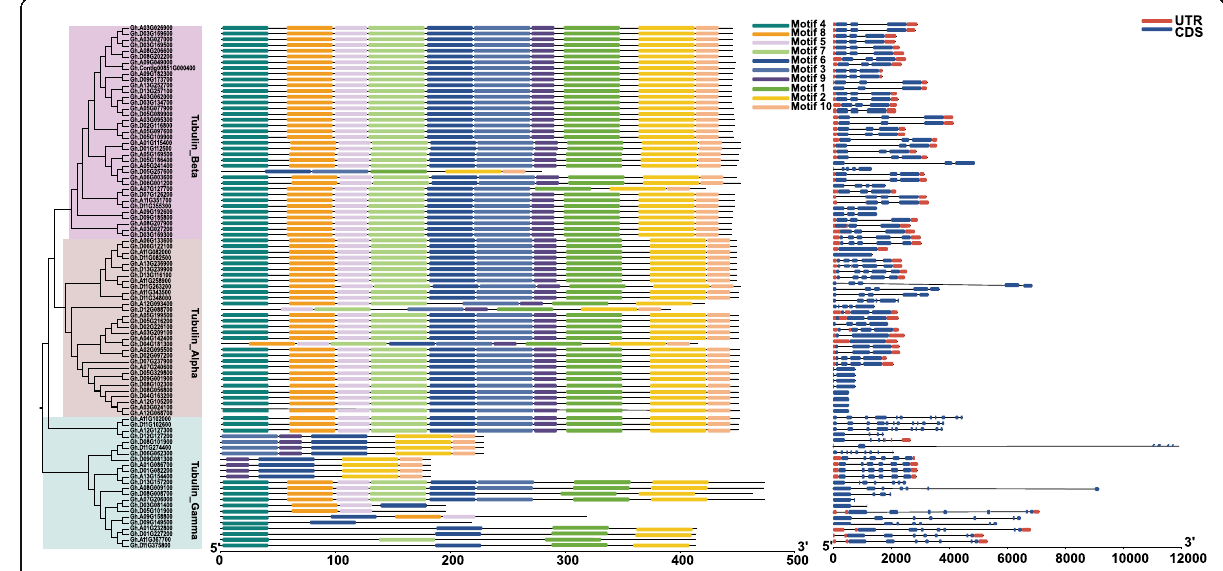
Fig. 2 Phylogenetic relationship, conserved motif, and gene structural characterizations analysis of tubulin genes in G. hirsutum . A neighbor- joining phylogenetic tree was created using the MEGA7 program, conversed protein motifs, and gene structure